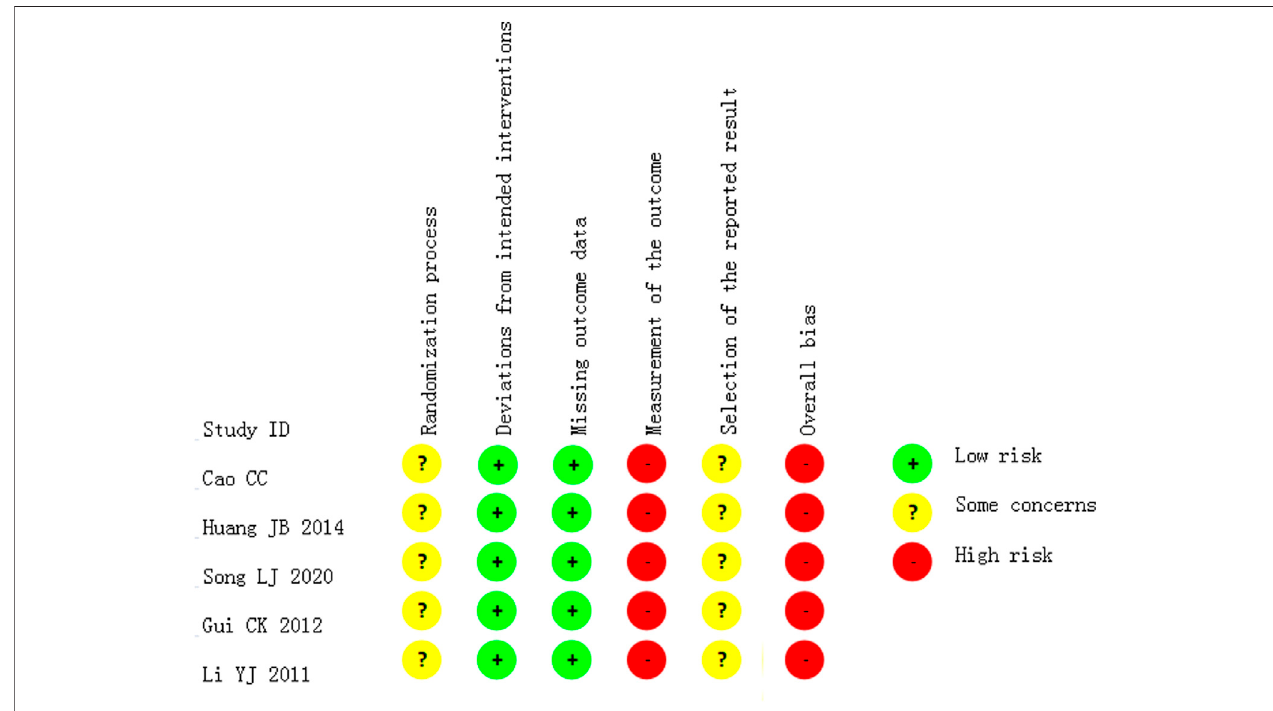
FIGURE 3 | Risk of bias in the studies which reported the outcome of improvement in global symptoms or nasal discharge and cough.